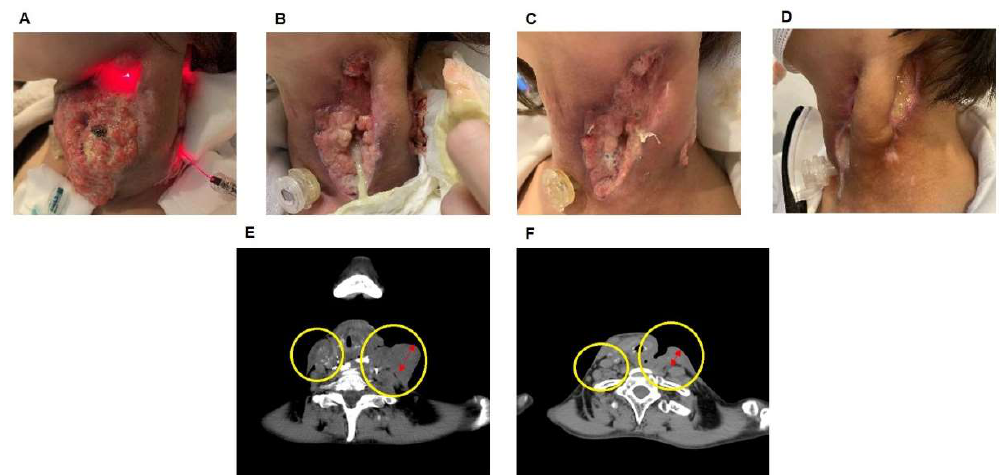
Figure 3. ( A ) Image immediately after the start of photodynamic therapy (PDT) using ICG liposomes. Laser irradiation of 635 nm and 810 nm was applied to the neck via optical fiber for 40 min. ( B , C ) A similar PDT with ICG liposomes was performed three additional times every other month. ( D ) Four months after the start of treatment, no tumor tissue was observed. ( E ) CT image before photodynamic therapy. ( F ) CT image during photodynamic therapy.